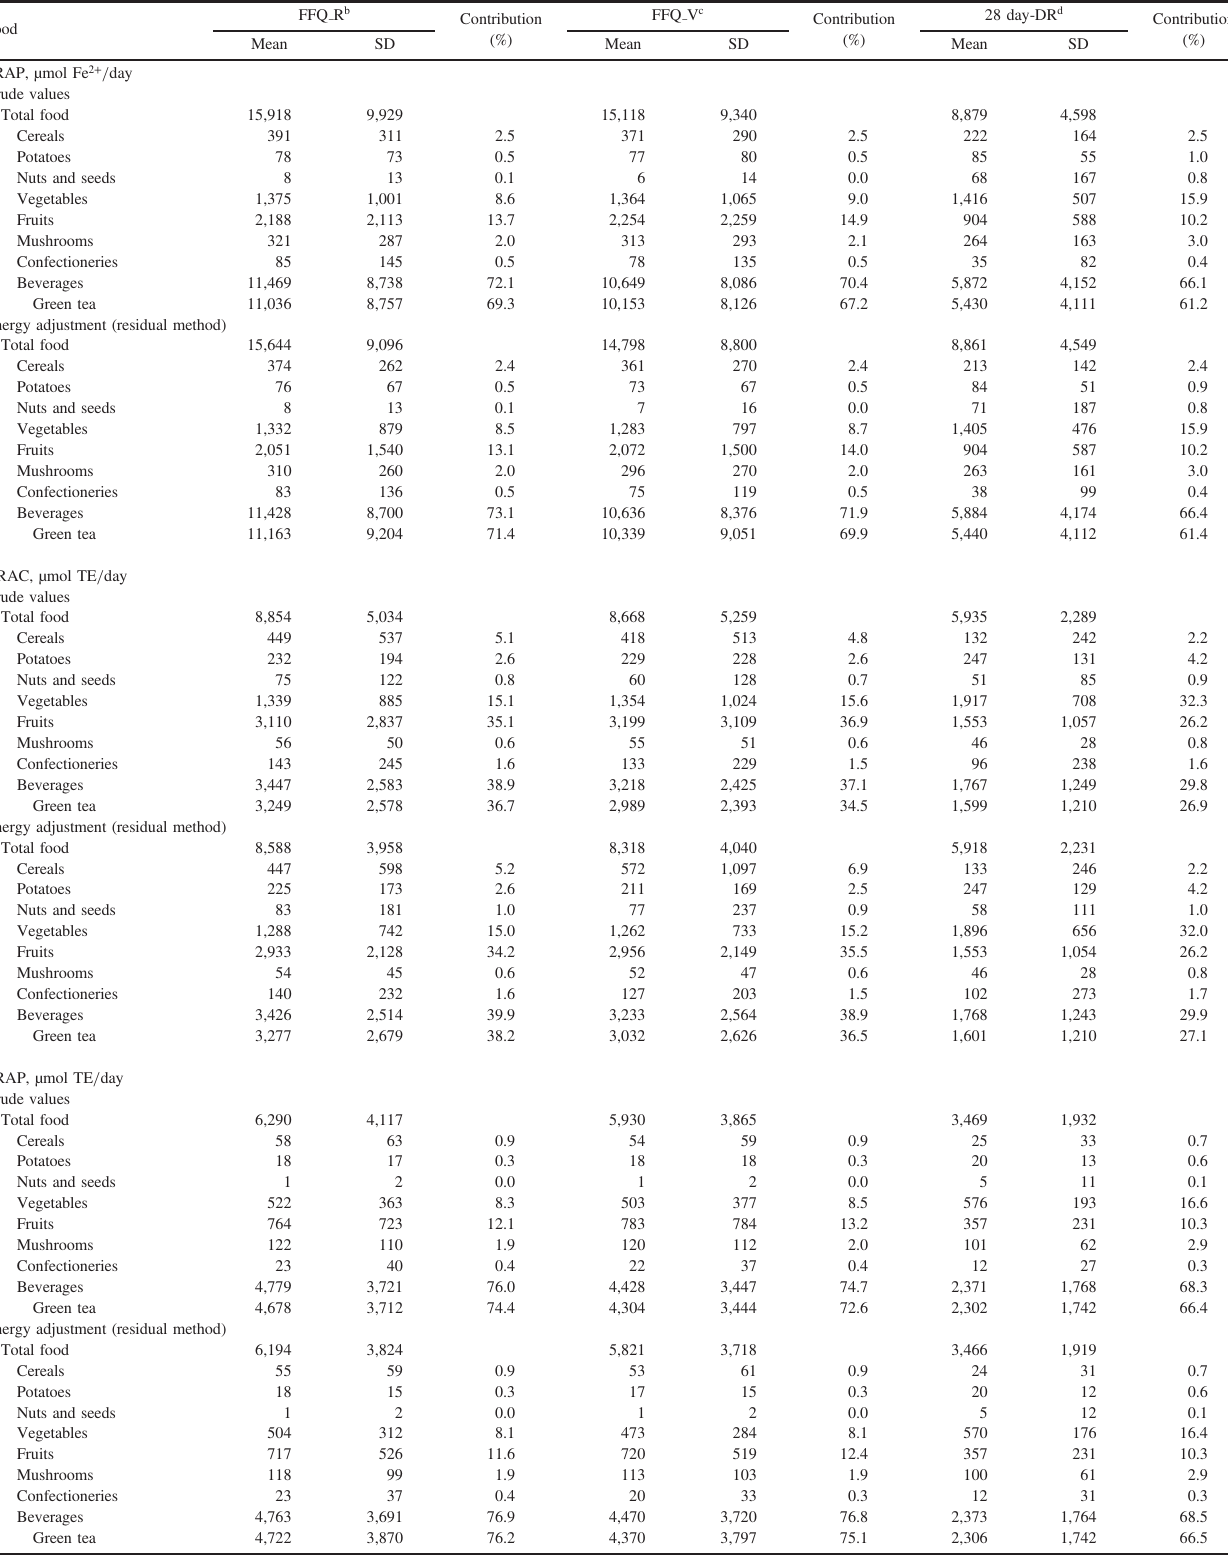
Table 1. Dietary antioxidant capacity of the food and beverage groups in men and women ( n = 497) a